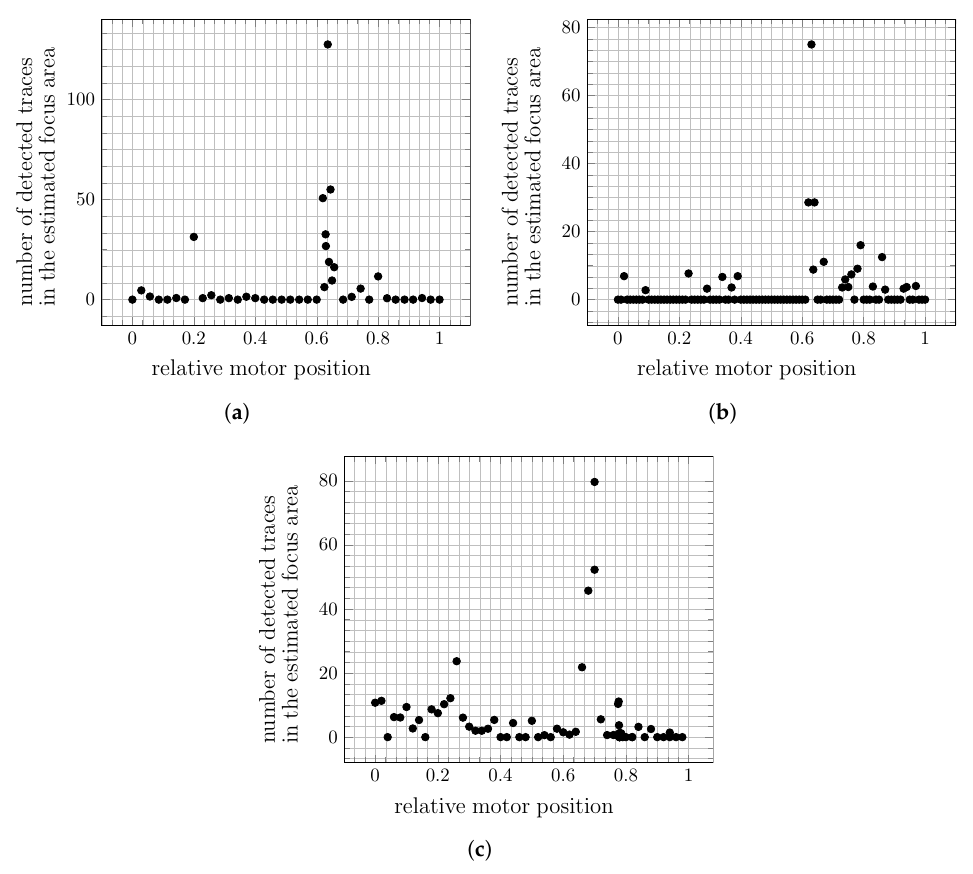
Figure 16. Sum of particle traces detected in the proposed focus region of each motor position. The detection follows the process described in Figure 9. The positions showing focus regions were determined by an expert at approximately ( a ) 0.64, ( b ) 0.63, and ( c )